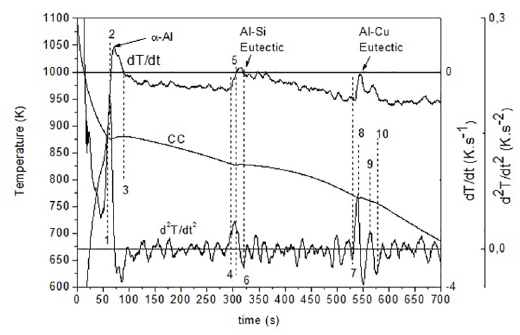
Figure 2. The cooling curve, the first and second derivative curves (dT/dt and d 2 T/dt 2 respectively) of Al-5Si3Cu alloy solidified in tec-tip standard cup.